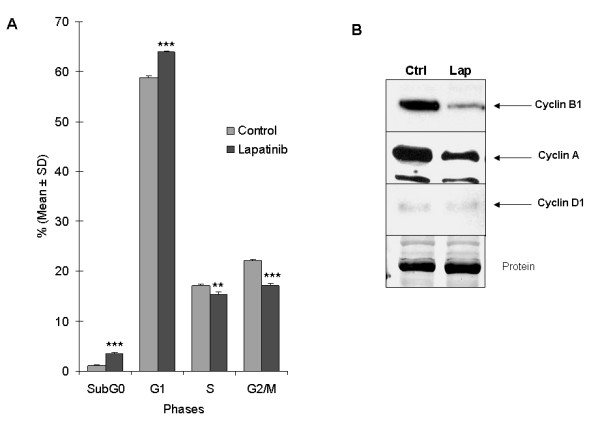
Cell cycle study of A549 cells treated with lapatinib. A. Lapatinib significantly alters cell cycle phases (G1 arrest and DNA synthesis reduction) analyzed by flow cytometry after propidium iodide staining (**: P < 0.01; ***: P < 0.001); B. Western blot showing the effect of lapatinib on the expression of the cell cycle regulators cyclins A, B1 and D1. In treated cells, the lower levels of cyclins A and B1, regulators of S and G2/M stages, respectively, corroborated the results described by cytometry. Levels of cyclin D1, a regulator of the G1 phase, were very low and remained unchanged upon treatment.